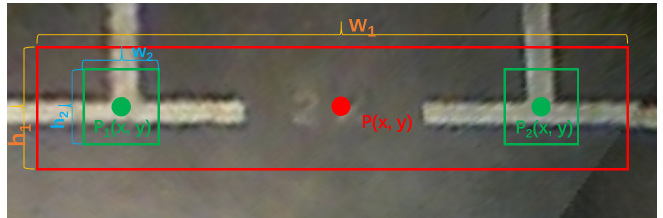
Figure 4. The bounding boxes of the parking slot head and marking points. Each bounding box consists of three parts: coordinates of the center point, width, and